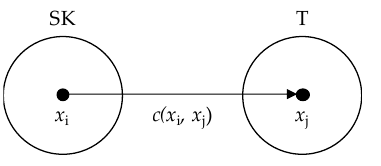
Figure 3. The optimal expansion process of a competence set.